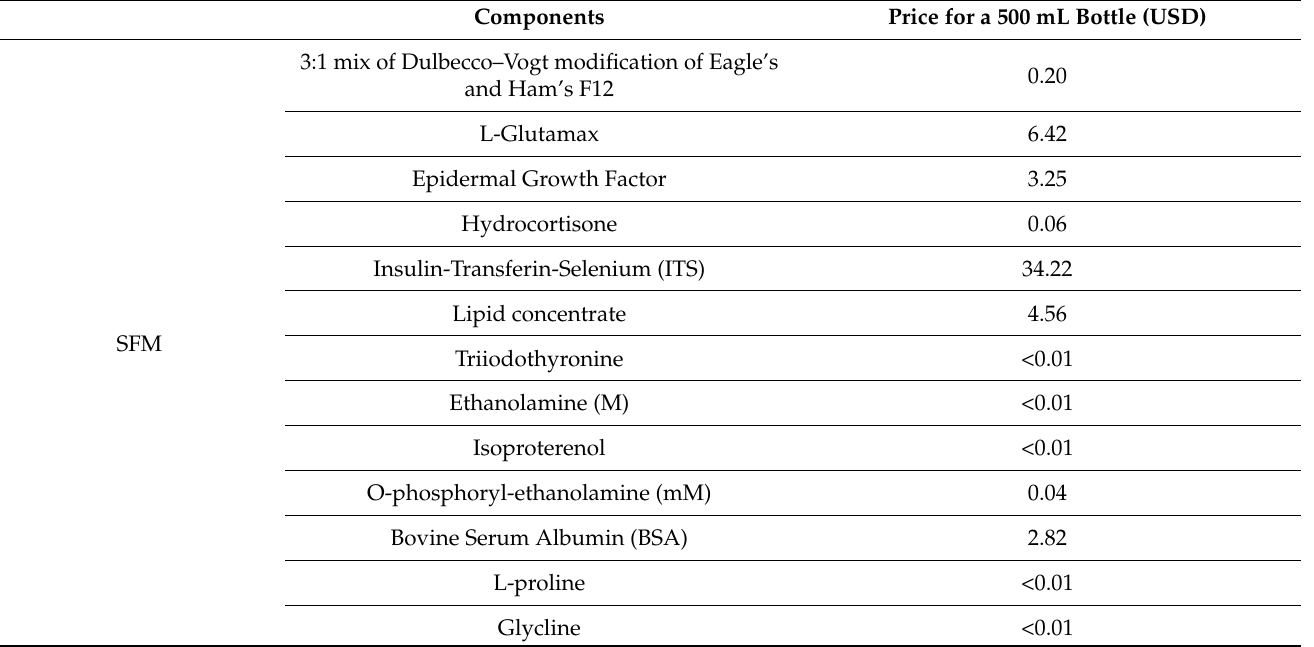
Table 3. Cost evaluation of SFM and FBSCM according to their ingredients. Prices marked as <0.01 are inferior to 0.01